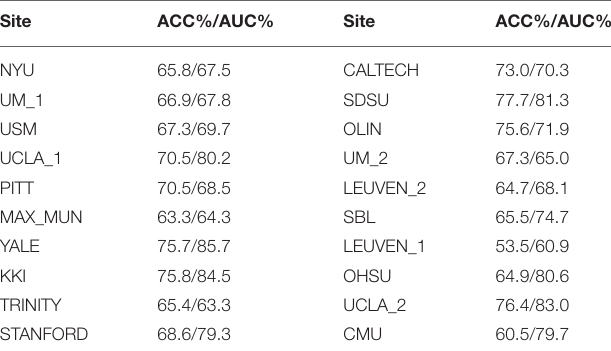
TABLE 3 | Leave-one-site-out autism spectrum disorder (ASD) classification performance of functional graph discriminative network (FGDN) on the Autism Brain Imaging Data Exchange (ABIDE)